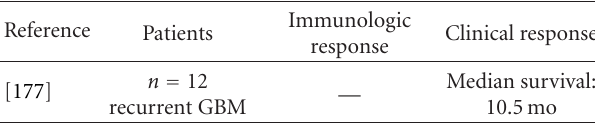
Table 6: Selected clinical trials using heat shock proteins